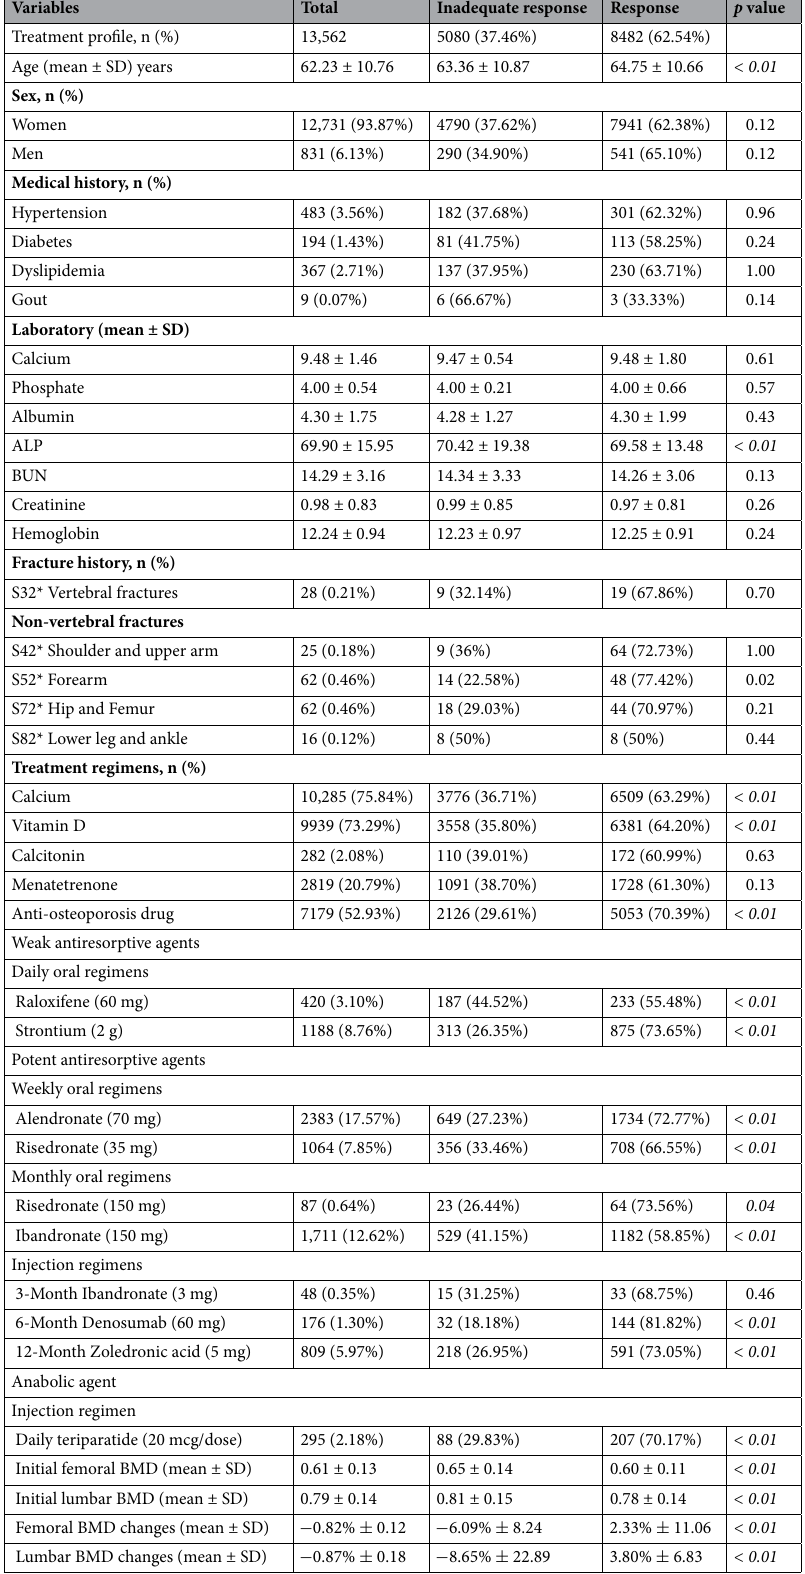
Table 1. Baseline characteristics and clinical features of study population with inadequate response and adequate response of BMD after treatment. p value significant at 0.05 level. Italics font in the " p value" column emphasizes the statistical significance at p value <